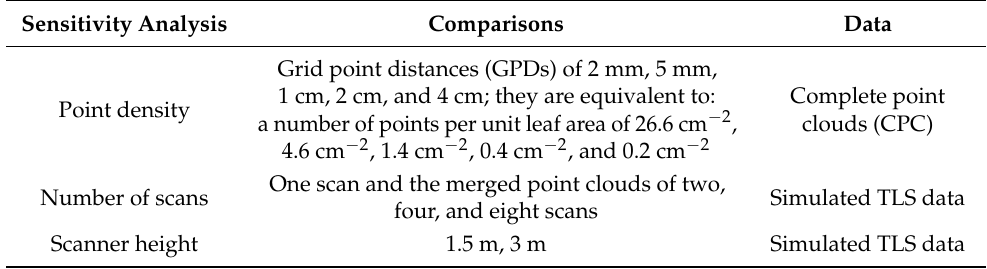
Table 1. Sensitivity